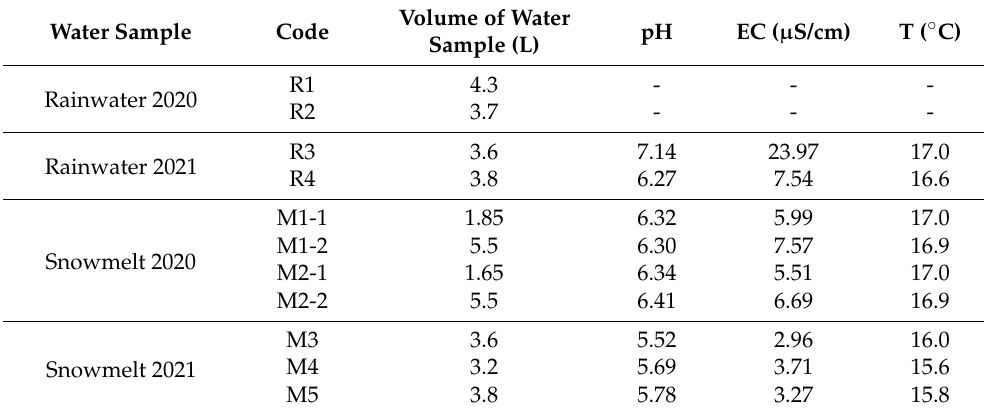
Table 2. Physico-chemical parameters (pH, electrical conductivity) measured in snowmelt and rainwater samples and volume of water